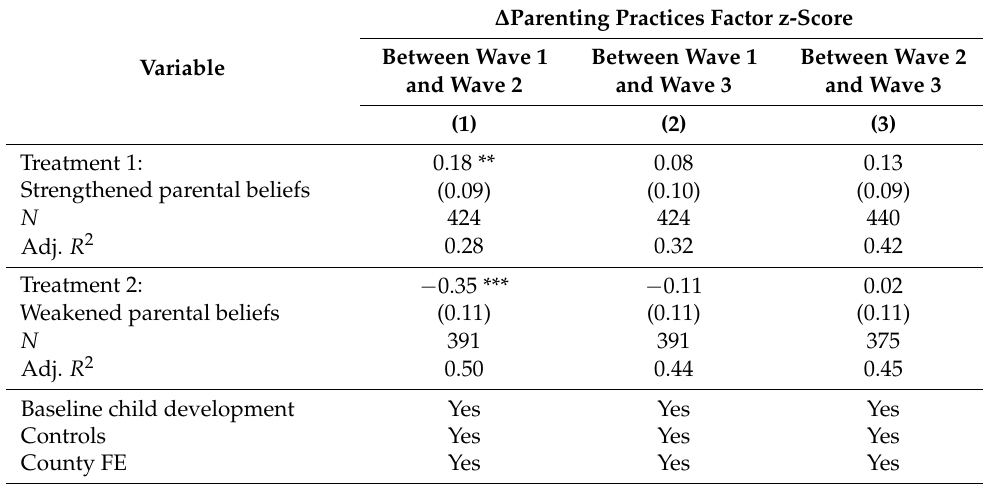
Table 5. Impact of strengthened and weakened parental beliefs on parenting practices.